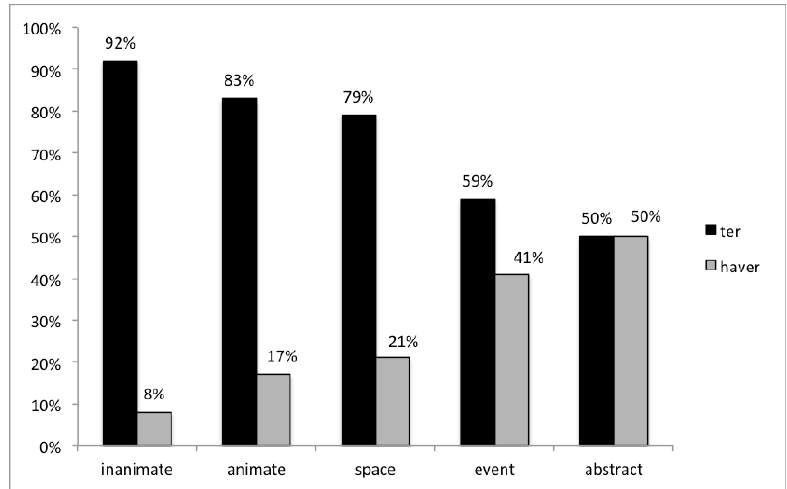
Figure 4 – Frequency of ter/haver by type of semantic